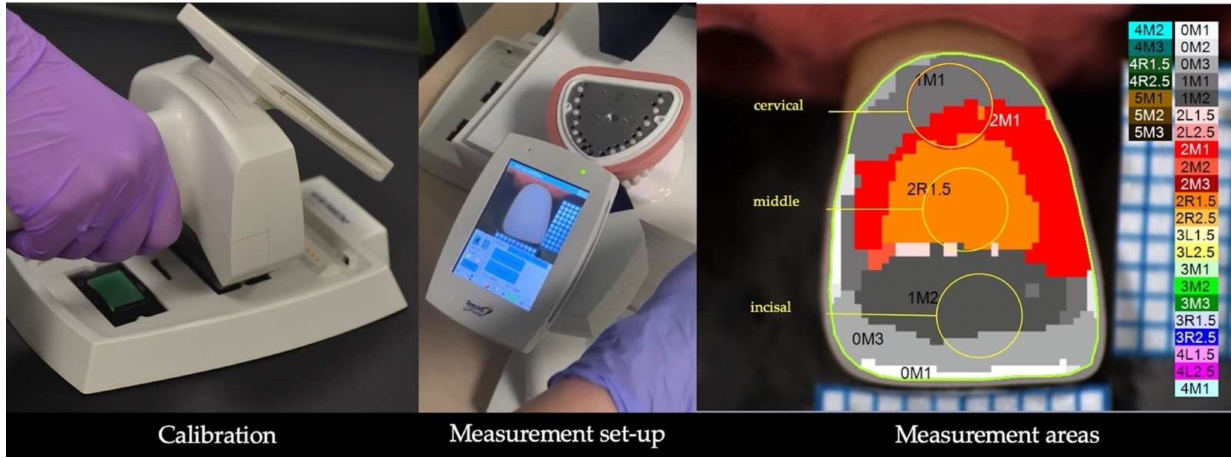
Figure 3. The eleven substrates made of resin composite (ND1–ND9), zirconia, and metal.